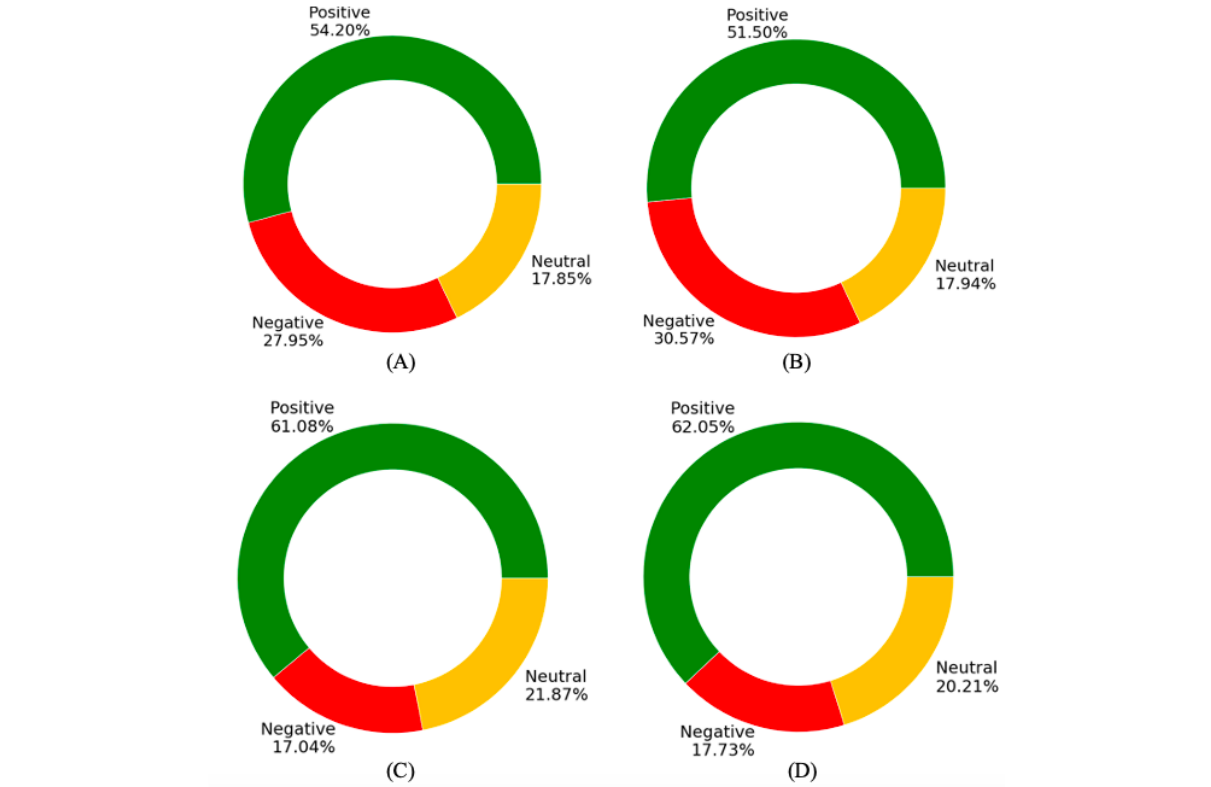
Figure 5. Overall averaged sentiments: (A) Twitter sentiments in the United Kingdom, (B) Twitter sentiments in the United States, (C) Facebook sentiments in the United Kingdom, and (D) Facebook sentiments in the United